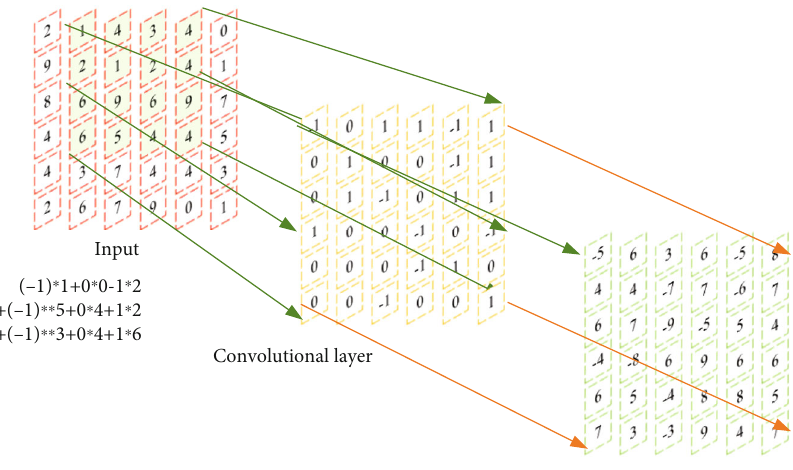
Figure 1: Convolution